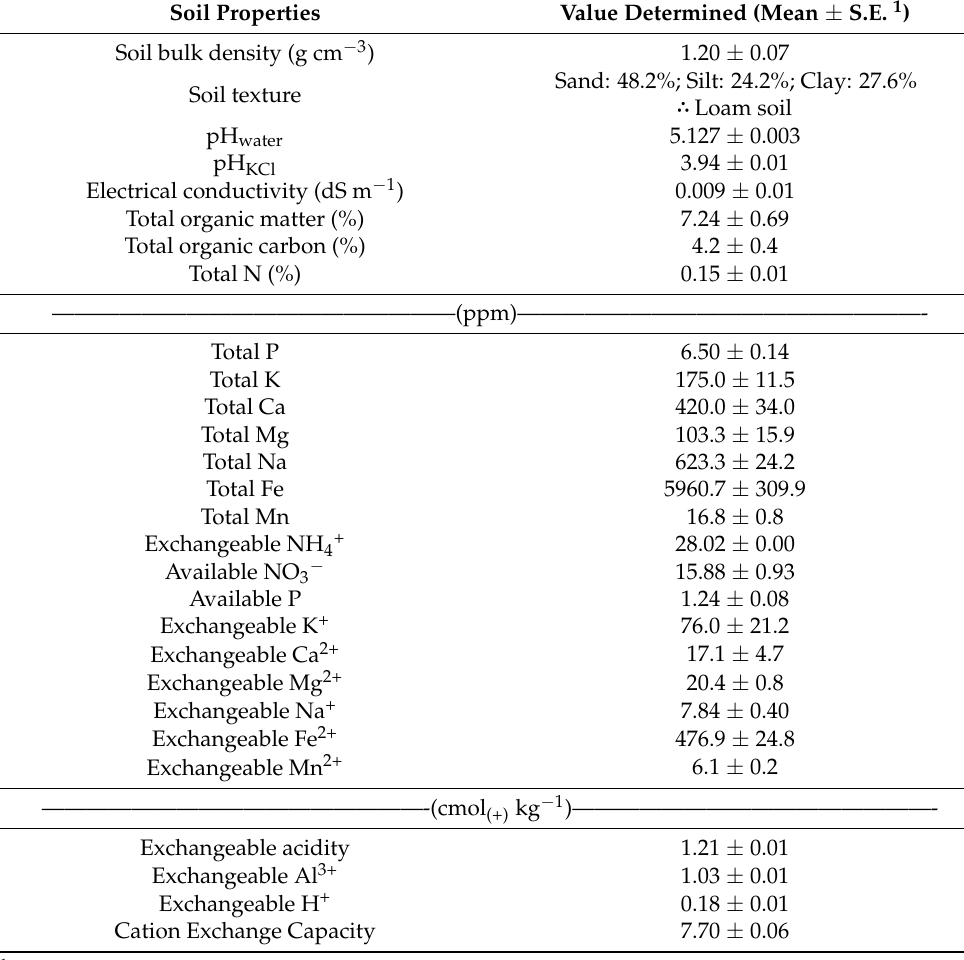
Table 2. Selected physio-chemical properties of Bekenu series ( Typic Paleudult ).